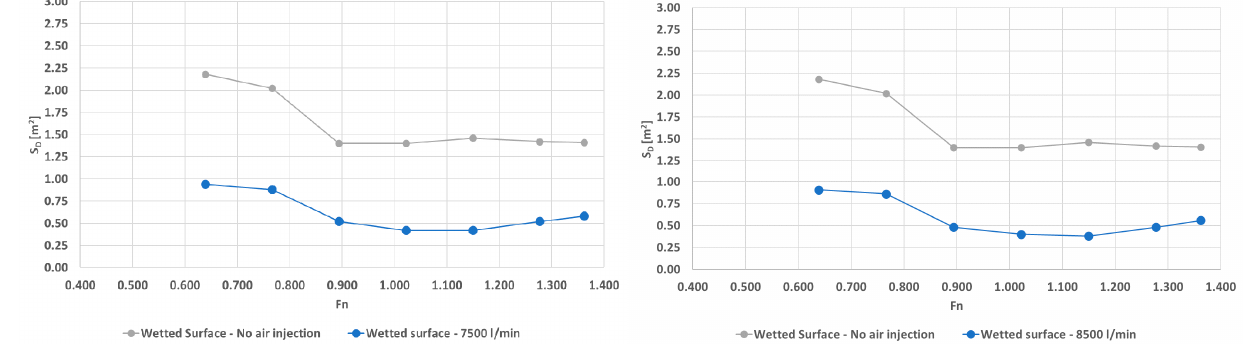
Figure 17. Wetted surface comparison–Air (7500 L/min and 8500 L/min) and No air.